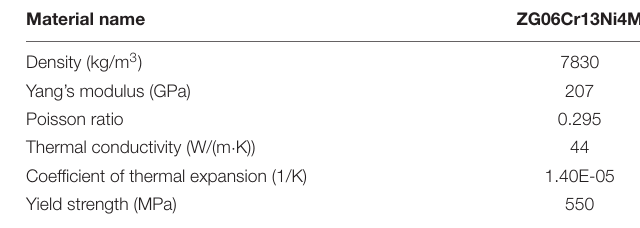
TABLE 2 | Material physical property